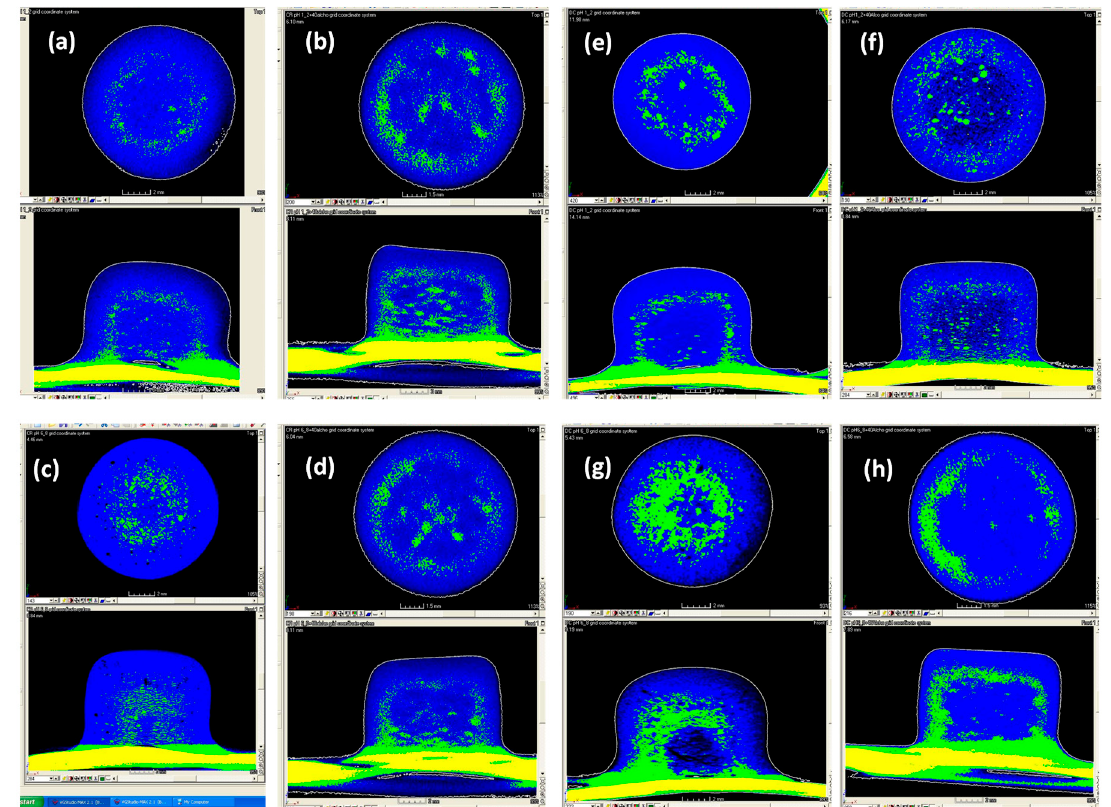
Figure 6. X-ray micro-tomographic images of the sagittal and transverse sections of the HPMC CR formulations in ( a ) pH 1.2 (0% absolute ethanol), ( b ) pH 1.2 (40% absolute ethanol), ( c ) pH 6.8 (0% absolute ethanol) and ( d ) pH 6.8 (40% absolute ethanol) for up to 7 h. X-ray micro-tomographic images of the sagittal and transverse sections of the HPMC K100M DC formulations in ( e ) pH 1.2 (0% absolute ethanol), ( f ) pH 1.2 (40% absolute ethanol), ( g ) pH 6.8 (0% absolute ethanol) and ( h ) pH 6.8 (40% absolute ethanol) for up to 7 h.